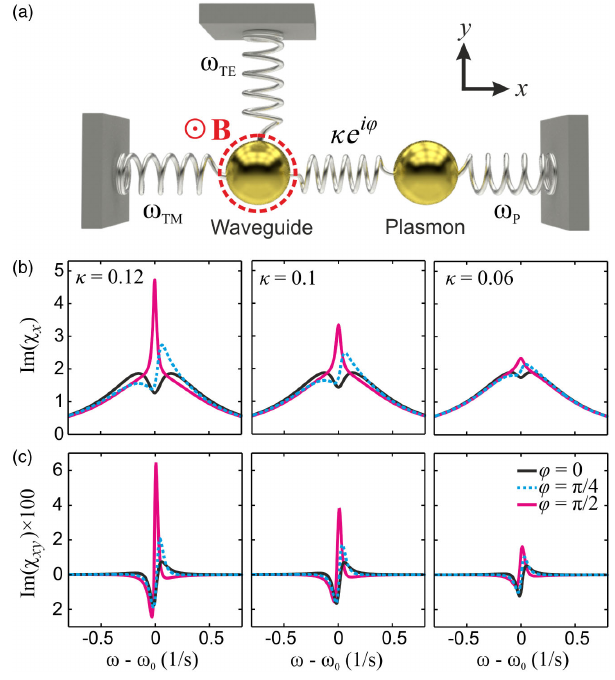
FIG. 6. (a) Oscillator model representing the magnetoplasmonic nanostructure. A precondition for EIA is that the coupling between the TM waveguide mode and the plasmon mode is weak and includes retardation. This is taken into account by the complex coupling constant κ exp ð i ϕ Þ with phase ϕ . (b) Imaginary part of the component χ x , which is proportional to the absorbance of x -polarized incident light. (c) Imaginary part of χ xy , which induces polarization rotation of both x - and y -polarized incident